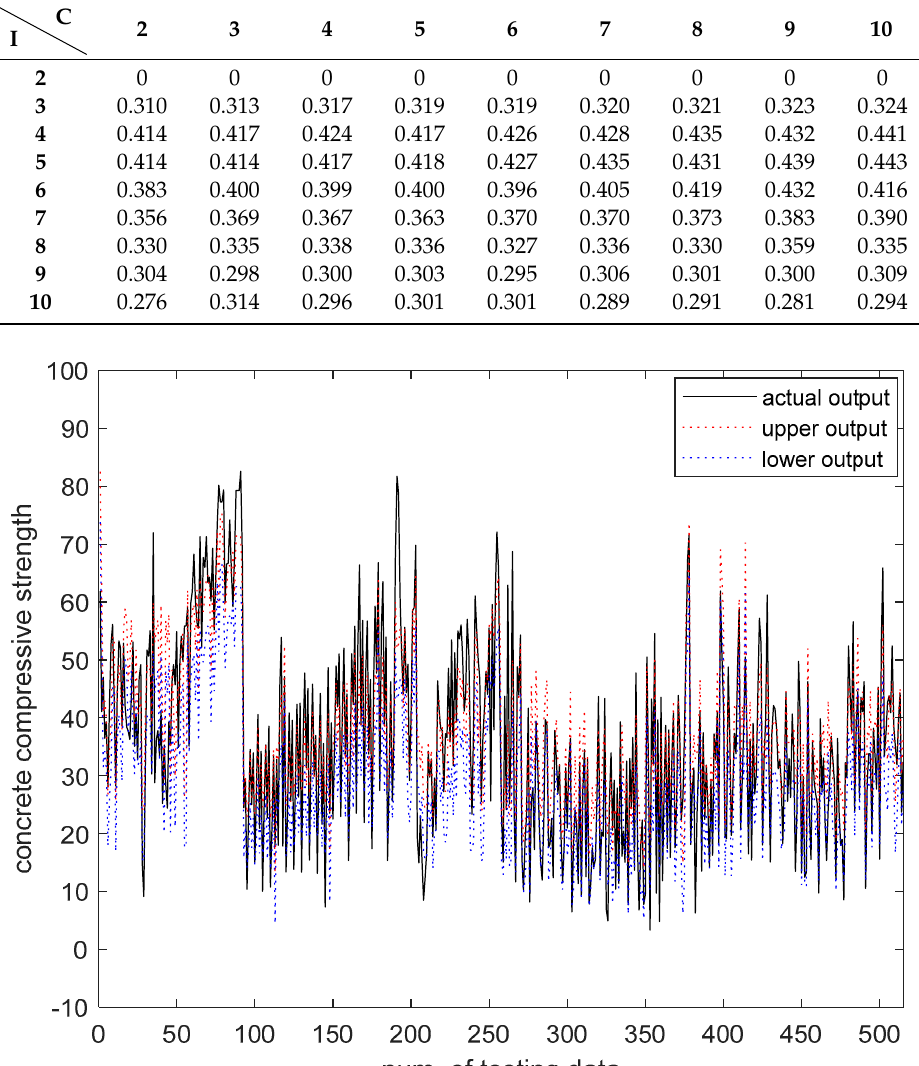
Table 6. CCS prediction results for interval-based IGM (Case 3) using testing data.